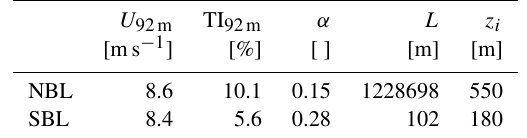
Table 4. Resulting flow parameters after reaching a stationary state in the precursor simulations, averaged over 3600s: the magnitude of the wind speed at hub height averaged over the model domain U 92m , turbulence intensity calculated at one position in 92m height TI 92m , shear parameter α (based on the power law u 2 = u 1 for the relation of wind speeds at different heights), Obukhov length L in a height of 2.3m and boundary layer height z i .